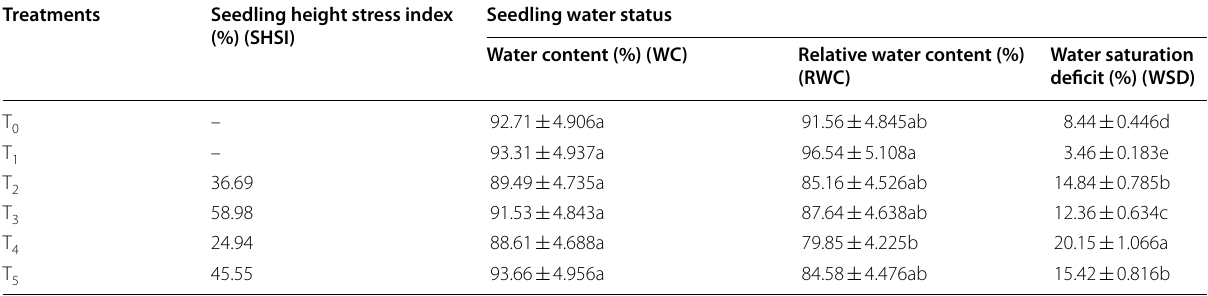
T 0 , T 2 and T 4 represent tomato seedlings grown on MS medium under 0, 50 and 100 mM NaCl stress, while T 1 , T 3 and T 5 represent tomato seedlings grown on MS medium with T. viride under 0, 50 and 100 mM NaCl stress * Data are mean of 5 replicates standard error ± Different letters in the same column mean significant difference at the p < 0.05 level by Duncan’s new multiple range test